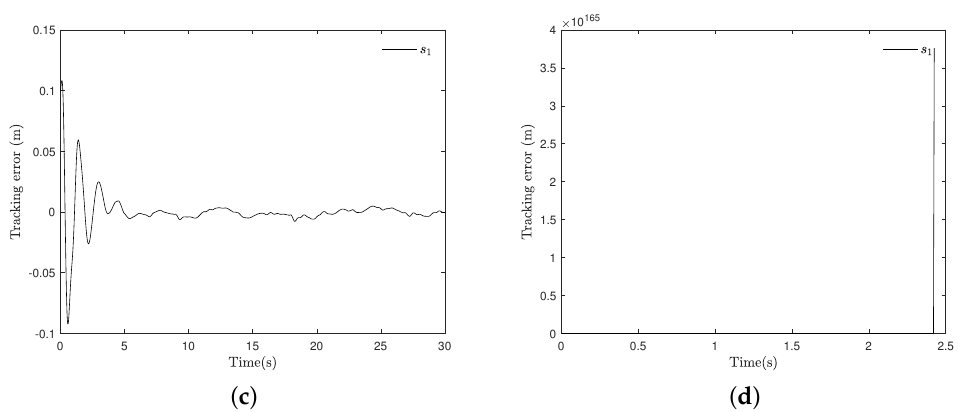
Figure 4. Comparison of tracking results and errors for Example 2: ( a ) y and y r of the proposed control system; ( b ) y and y r of the control system presented in [24]; ( c ) s 1 of the proposed control system; and ( d ) s 1 of the control system presented in [24].